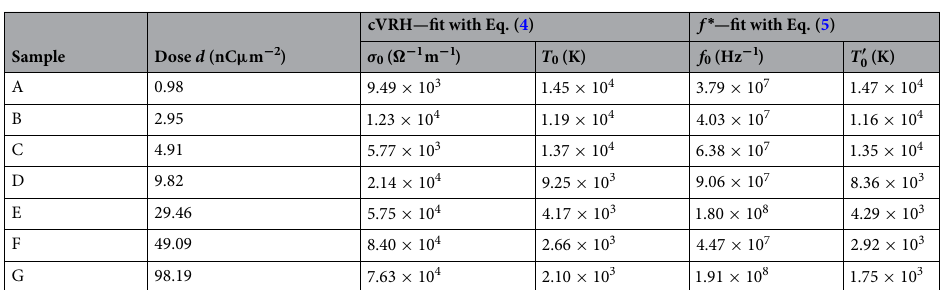
Table 1. Overview of selected parameters characterizing the set of Pt/C samples with increasing tunnel- coupling strength from sample A to G, tuned by the corresponding post-growth irradiation dose d . Parameters σ 0 and T 0 are extracted from the temperature-dependent DC conductance of the samples. Parameters f 0 and T ′ 0 follow from the analysis of the imaginary part of the impedance Z ′′ ( f ) . See text for details.